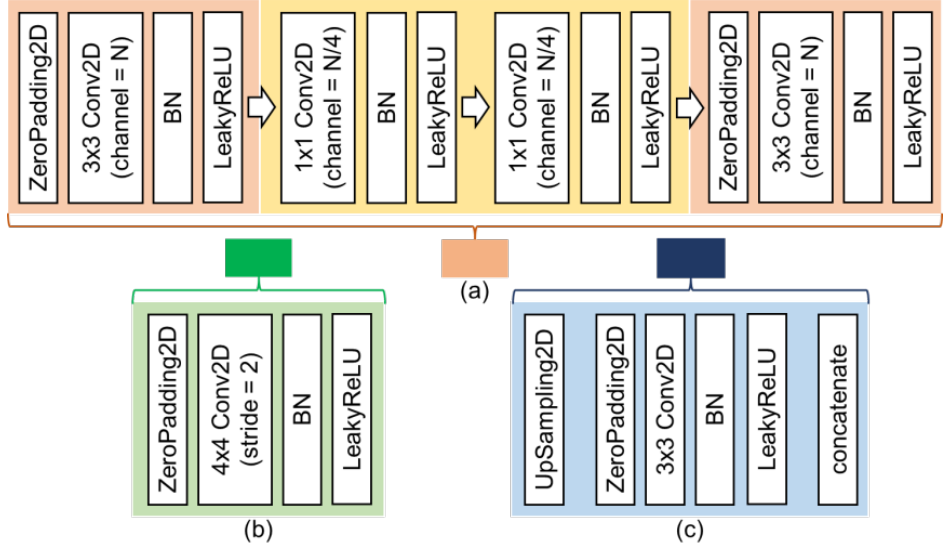
Padding2D” refers to the 2D padding layer using the value zero. “3 × 3 Conv2D (channel = N)”